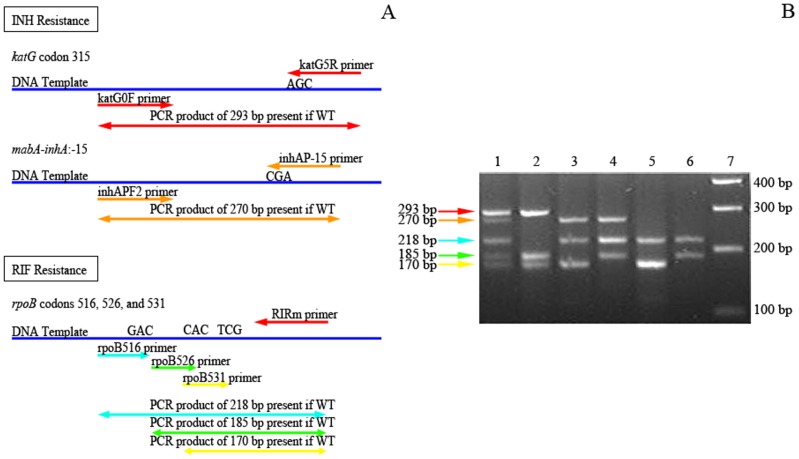
Distinct band patterns indicate drug resistance profile of isolates.A. Loci where each allele-specific primer binds are indicated, along with the expected product size if the locus is wild-type. The two common mutations that confer resistance to INH and the three common mutations that confer resistance to RIF are boxed separately. B. Band patterns indicate drug resistance profile of isolates. Expected PCR products have been color-coded in the same way as in A. Lane 1: H37Rv reference strain (wild-type at all 5 loci); Lane 2: mabA-inhA −15C→T and RpoB D516F double mutant; Lane 3: KatG S315T and RpoB H526Y double mutant; Lane 4: KatG S315G and RpoB 531L double mutant; Lane 5: mabA-inhA −15C→T, KatG S315T and RpoB H526D triple mutant; lane 6: mabA-inhA −15C→T, KatG S315T and RpoB S531L triple mutant; Lane 7: Molecular ladder.